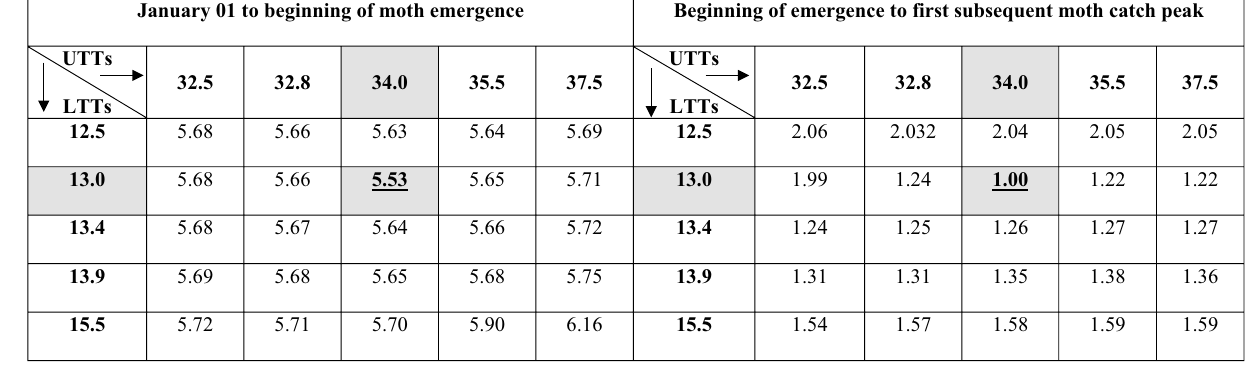
Table 1. Field calibration of optimum developmental threshold temperatures for cotton pink bollworm using coefficients of variation (CV) technique of degree-day accumulations calculated for male moth catches in sex pheromone traps observed for a period of 8 years using different combinations of lower and upper threshold temperatures. A combination with lowest CV is accepted as the best lower and upper threshold temperatures. Bold underline values represent the best combination of LTT and UTT (13.0/34.0 °C) which gave lowest value of coefficient of variation in degree days